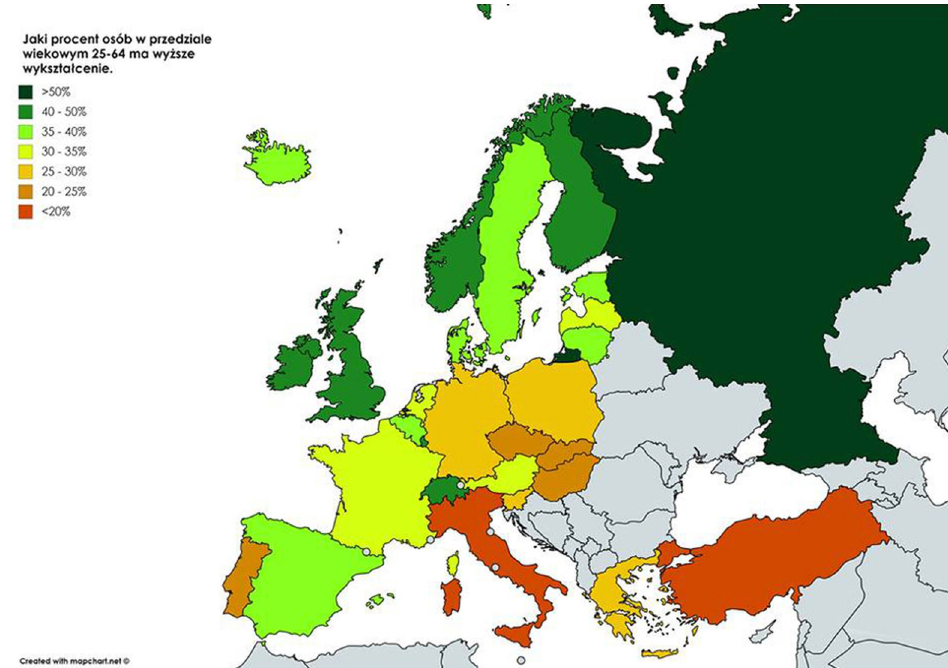
Fig. 2. Map posted in the analysed group showing the percentage of people aged 25–64 with a university degree. Relative data choropleth map with a hypsometry-like colour scale not matching the